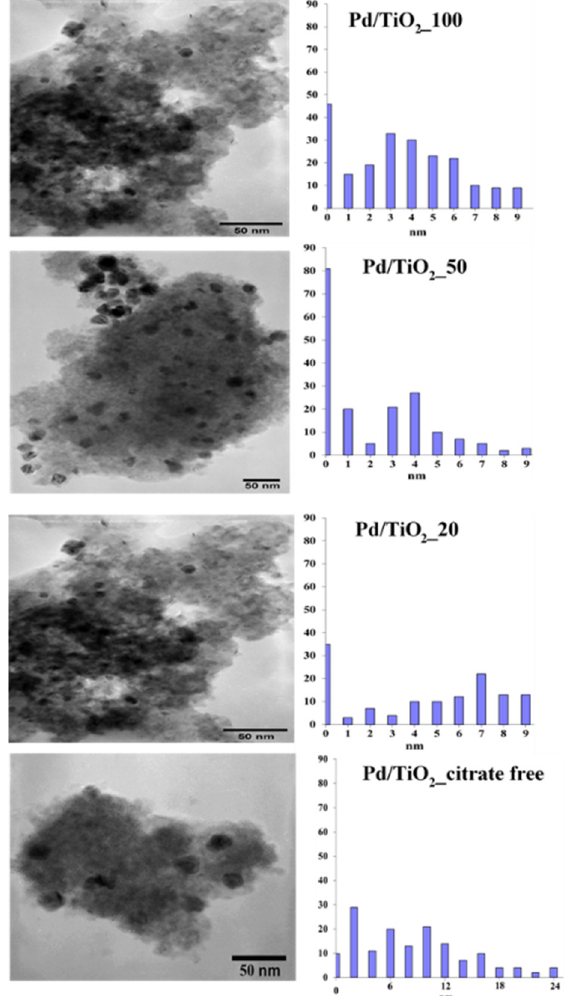
Figure 5. TEM pictures of the Pd/TiO 2 _x (x = 20, 50, and 100) catalysts and Pd/TiO 2 _citrate free after drying at 70 °C for 24 h.